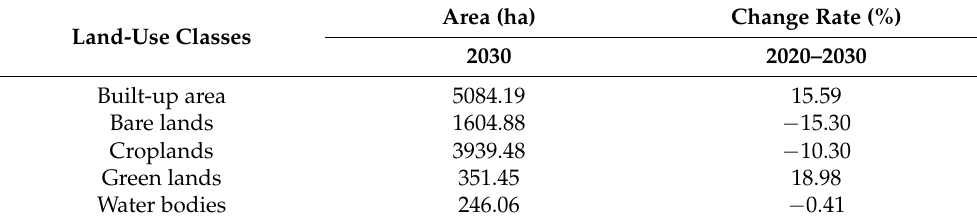
Table 5. Land-use areas in 2030 and their change rate (%) compared to 2020. Land-Use Classes